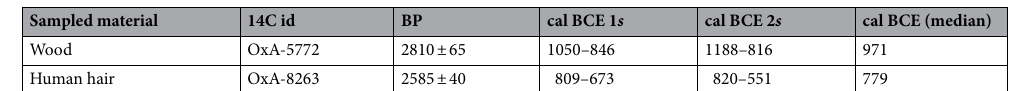
Table 1. Valid radiocarbon dates for the trilobed lid from Chamber 5 of the cave of Es Càrritx 89,146,147 (calibration using OxCal v4.4.4 and applying IntCal20 calibration curve) 148,149